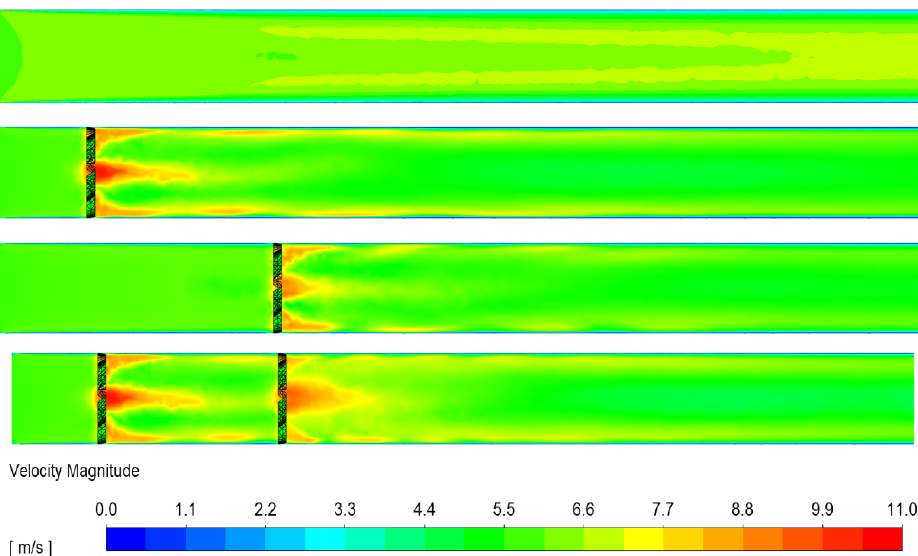
Figure 11. The velocity distribution of different mixers at 0.1 s.